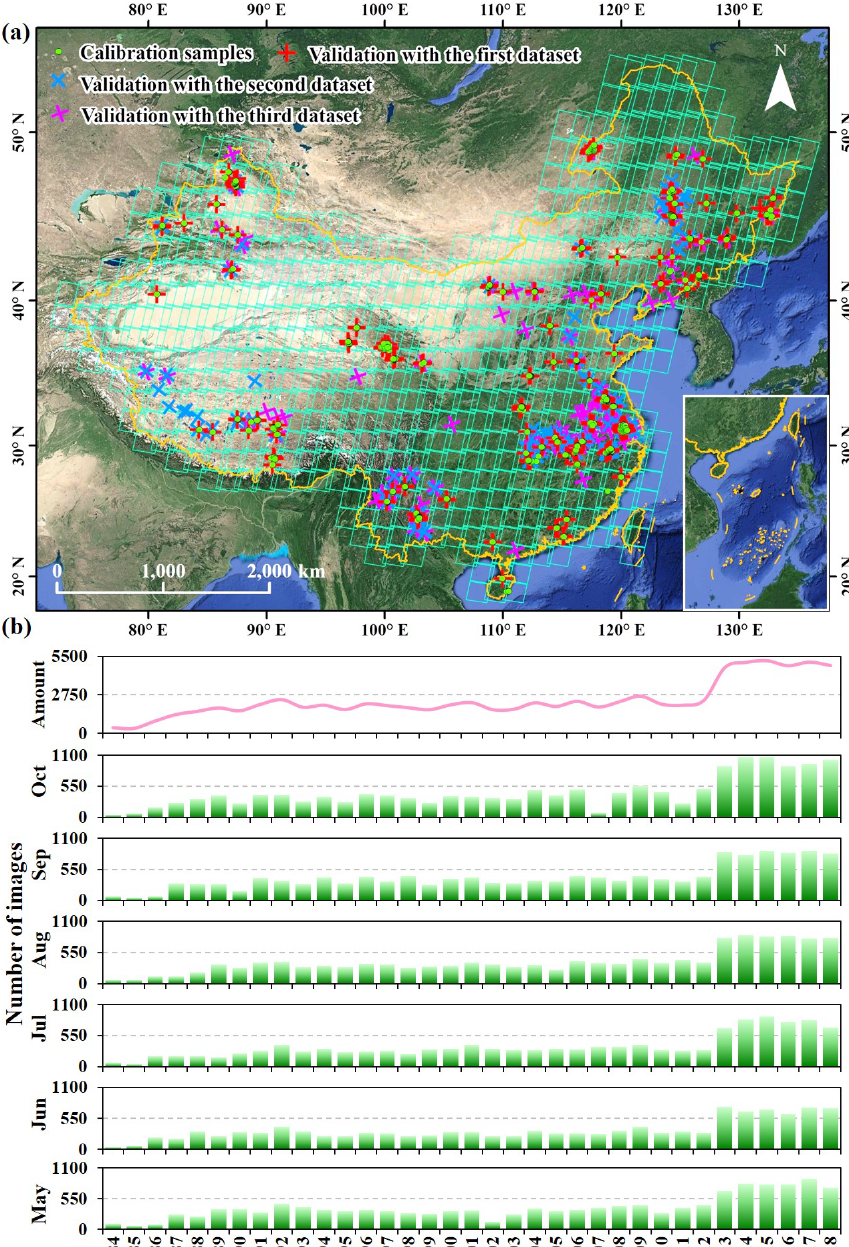
Figure 2. Location of the sampled water bodies (lakes or reservoirs) and Landsat Worldwide Reference System 2 (WRS-2) path/row based on ©Google Earth images across China (a) . Number of Landsat scenes used in ice-free season from 1984 to 2018 (b) .